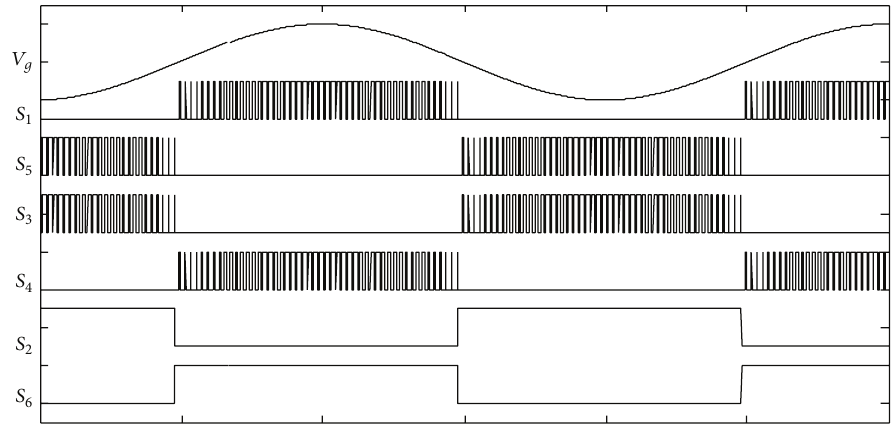
Figure 3: Switching state of the proposed inverter circuit.